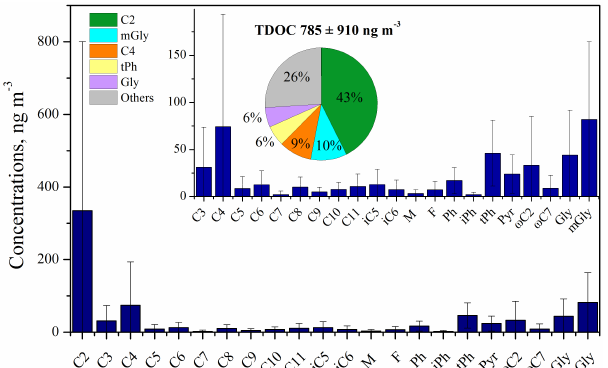
Figure 3. Molecular distributions of dicarboxylic acids and related compounds in PM 2 . 5 of Beijing, China, during the 2014 APEC campaign. The pie chart is the average composition of total detected organic compounds (TDOC) and the top number is the average mass concentration of TDOC of the whole study